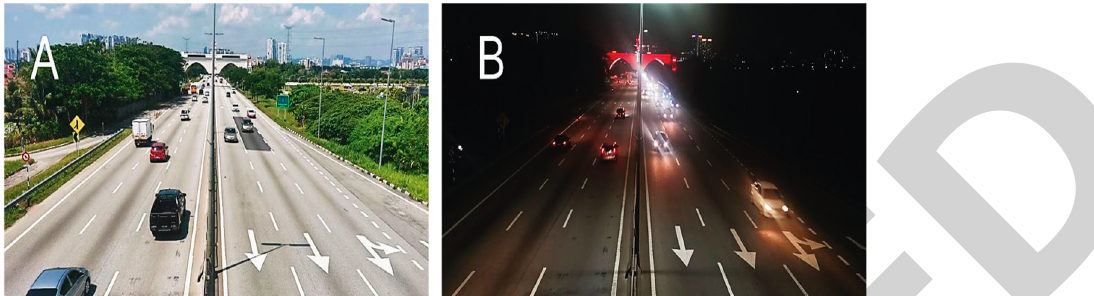
Figure 2: Examples of images from the camera taken at daytime (a) and nighttime (b) without weather interruptions.